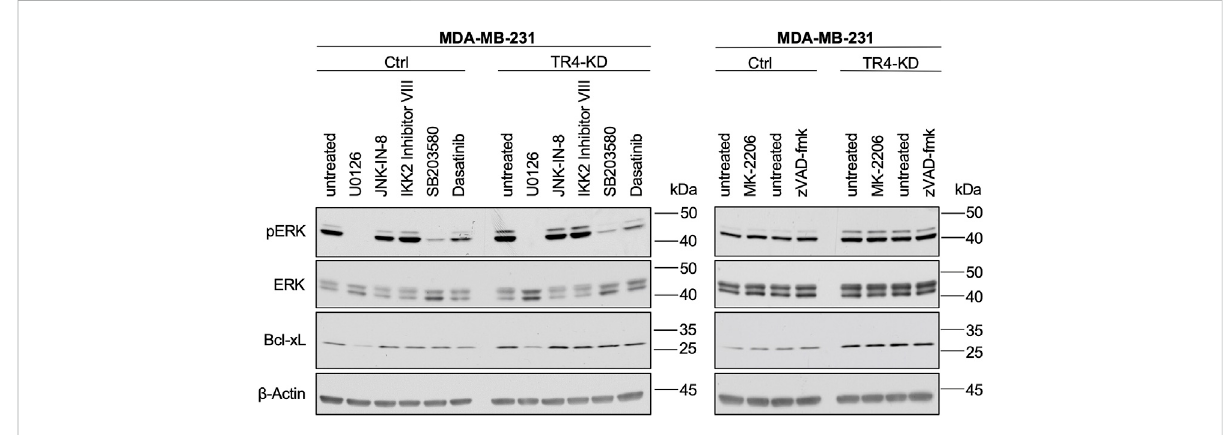
FIGURE 10 Inhibition of MEK1/2 leads to a strong decrease of Bcl-xL in MDA-MB-231 cells. MDA-MB-231 control (Ctrl) and TRAIL-R4-knockdown (TR4- KD) cells were seeded at 2 – 4 × 10 6 cells/well in 6-well format and 24 h later stimulated for 2 h with pharmacological inhibitors of different signal transduction pathways at the indicated concentrations: MEK1/2 (U0126; 10 µM), JNK (JNK-IN-8; 1 µM), IKK2 (IKK2 inhibitor VIII; 10 µM), p38 (SB203580;10 µM),Src(Dasatinib;100 nM),AKT(MK-2206;1 µM),broad-spectrumcaspaseinhibitor(zVAD-fmk;20 µM)orspeci fi csolventsas controls. Whole-cell lysates were analyzed by Western blot for the levels of pERK, ERK and Bcl-xL. Detection of β -Actin served as a loading control. Shown are representative pictures from one related experiment out of three biological